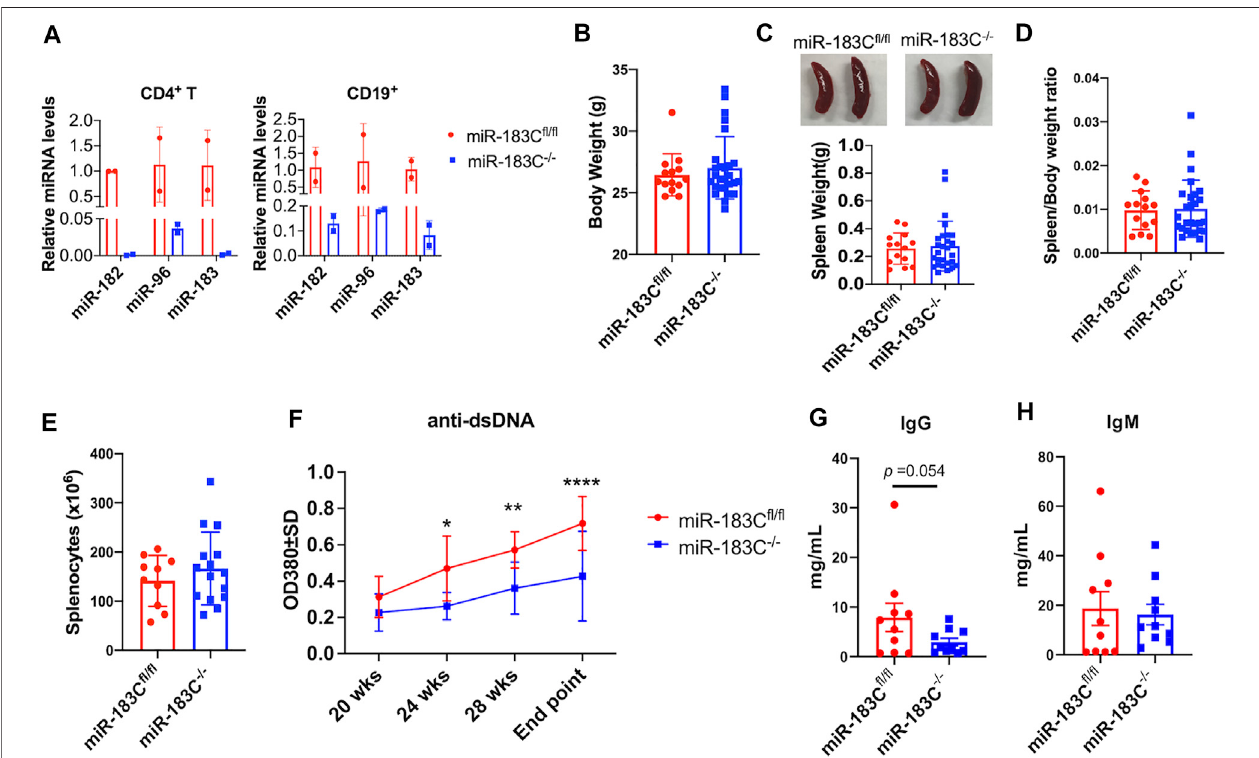
FIGURE 2 | Analysis of the effect of miR-183C deletion on body weight, spleen weight, and antibody production. (A) miRNA TaqMan assay was performed to validatethedeletionofmiR-182,-96,-183miRNAsinpuri fi edCD4 + TandCD19 + BcellsfromconditionalmiR-183C − / − B6/lpr(miR-183C − / − )mice.Dataarepresentedas means±SD( n =2each). (B – E) DeletionofmiR-183Chadnoobviouseffectonbodyweight (B) ,spleenweight (C) ,spleen/bodyweightratio (D) ,andsplenocytecounts (E) . The miR-183C − / − and control miR-183C fl / fl B6/lpr (miR-183C fl / fl ) mice were euthanized at 29 – 32 weeks of age (end point) for the assay. Data are displayed as means ± SD ( n ≥ 10). (F) Deletion of miR-183C miRNAs signi fi cantly reduced serum anti-dsDNA autoantibodies. The serum anti-dsDNA autoantibody levels in miR- 183C − / − and control miR-183C fl / fl mice were monitored every 4 weeks starting at 20 weeks of age. The graph showed means ± SD ( n = 6 for miR-183C − / − mice at different time points except n = 12 for the end point; n = 10 for 183C fl / fl mice at different time points except n = 15 for the end point). (G,H) Evaluation of serum levels of total IgG (G) and IgM (H) antibodies in miR-183C − / − and control mice at the end point. Graphs showed means ± SD ( n = 10 each). Unpaired student t tests were performed (miR-183C fl / fl vs . miR-183C − / − ); *, p < 0.05; **, p < 0.01.